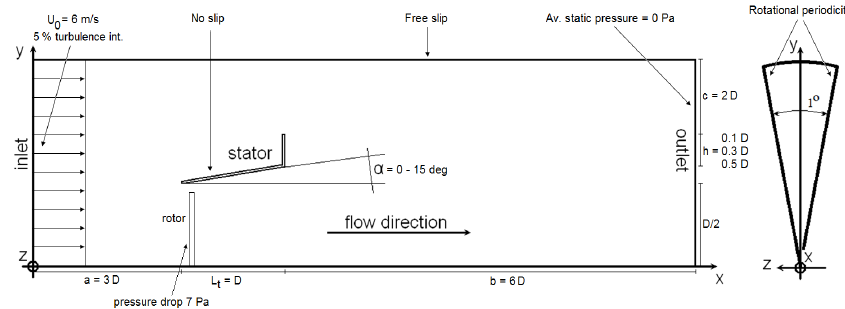
Figure 7: General view of the simulation domain for the calculations in rotor presence.